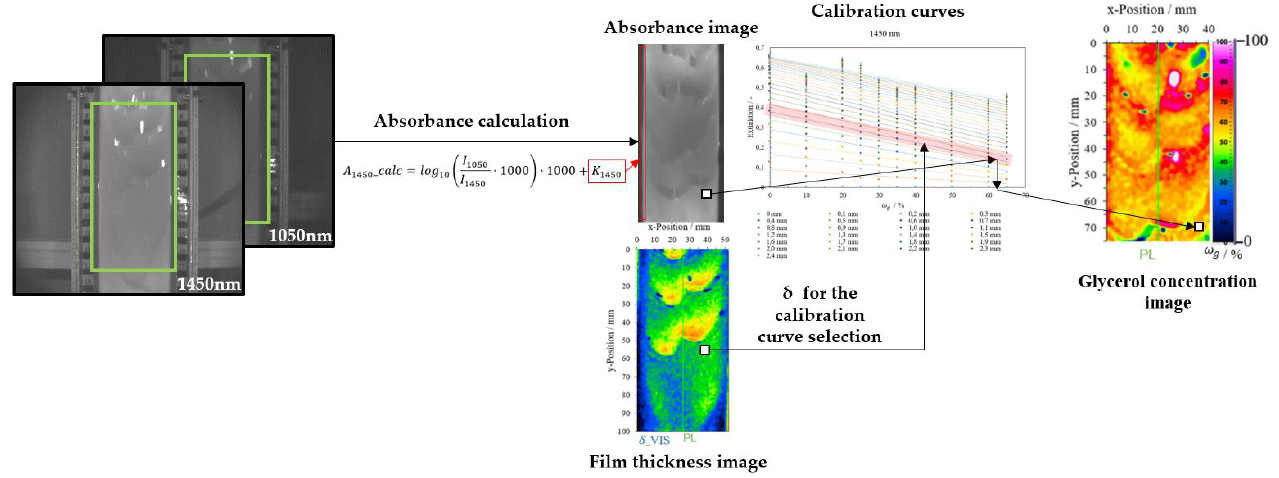
Figure 9. Workflow scheme for the determination of glycerol mass concentration in falling films using NIR image analysis .